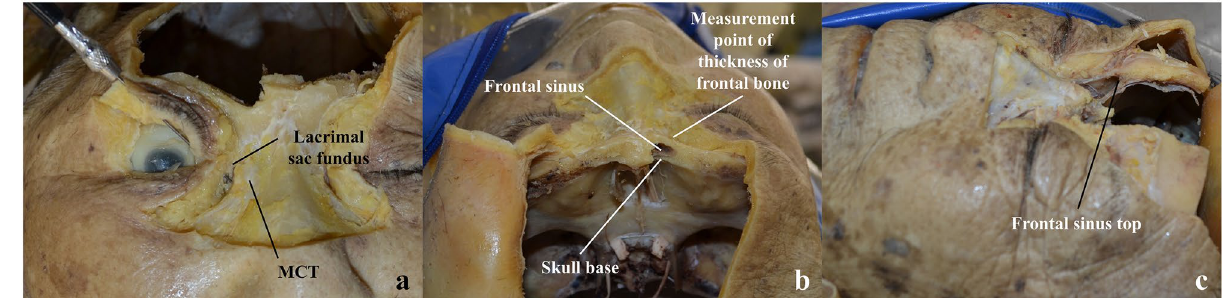
Figure 1. Cadaveric dissection. ( a ) A photo of a right orbit was taken from the front. The medial canthal tendon (MCT) and lacrimal sac fundus were exposed, and a probe was inserted from the lacrimal punctum to confirm the position of the common canalicular orifice. The frontal bone was removed up to the level of the skull base. ( b ) A photo of a right orbit was taken from the above. The frontal sinus lies between the lacrimal sac fundus and skull base. ( c ) A photo of a right orbit was taken from the left. The frontal sinus top at the vertical level of the lacrimal sac fundus was